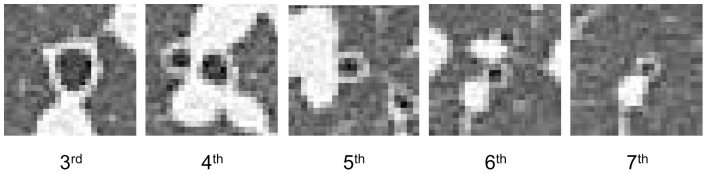
Examples of airways measured at different generations.The representative images of right posterior basal bronchi (3rd generation) and more distal bronchi of a healthy control on Aquilion 64 (Auto Exposure Control, 0.5-mm slice thickness, 350-mm FOV, lung reconstruction algorithm FC56). At the 6th to 7th generation, the thickness of the bronchus wall had equal or less than pixels size.